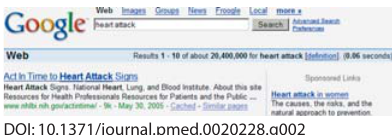
Figure 2. Results of the Search Term “Heart